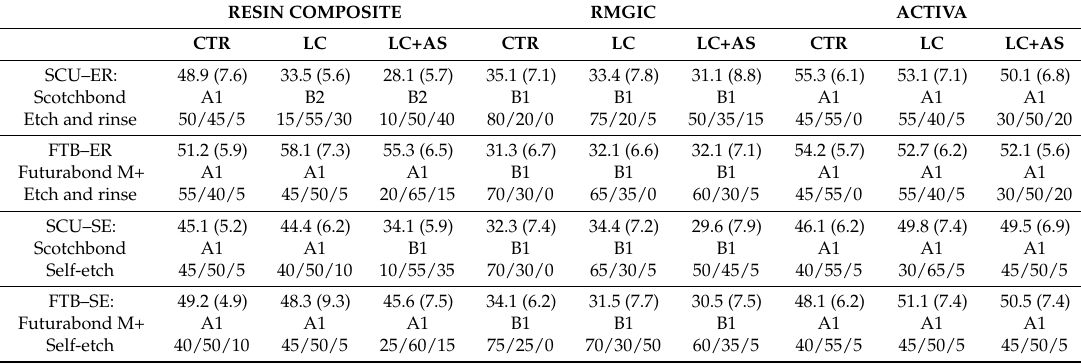
Table 3. The results show the mean ( ± SD) of the MTBS (MPa) to dentine and the percentage (%) of the failure mode analysis.